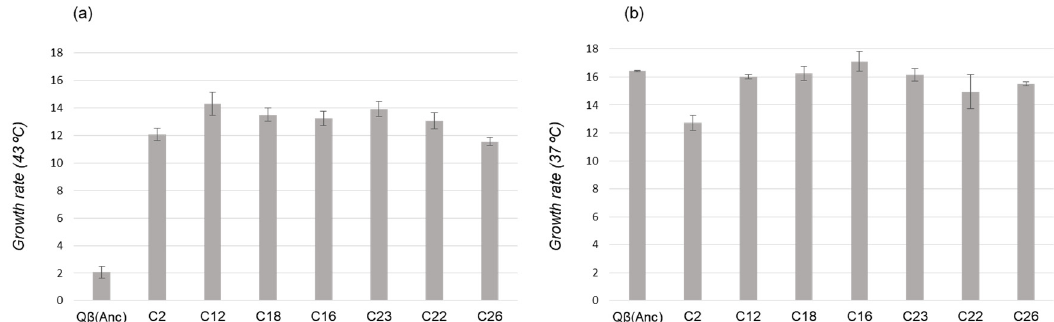
Figure 3. Growth rates of virus clones isolated from L1 at transfer number 15. ( a ) Growth rates determined at 43 ◦ C. ( b ) Growth rates determined at 37 ◦ C. Values were calculated as described in Materials and Methods (Section 4) and expressed as doublings per two hours. The virus Q β (Anc) was also included in the analysis for comparison. Error bars represent the standard deviation of three parallel replicas.